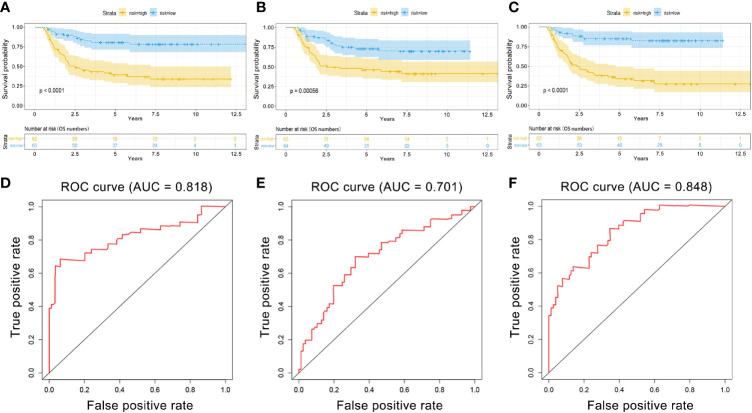
Kaplan–Meier (K–M) and ROC curves for PI in WT patients. (A) K–M survival curves between high-risk and low-risk groups based on lncRNA model. (B) K–M survival curves between high-risk and low-risk groups based on miRNA model. (C) K–M survival curves between high-risk and low-risk groups based on mRNA model. (D) Time-dependent ROC curves analysis for survival prediction by PIlncRNA. (E) Time-dependent ROC curves analysis for survival prediction by PImiRNA. (F) Time-dependent ROC curves analysis for survival prediction by PImRNA.